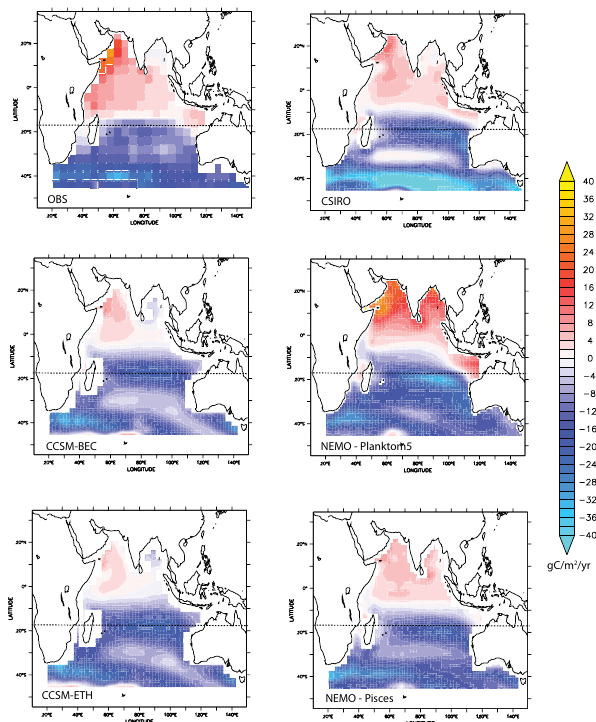
Fig. 4. Annual mean uptake, in gCm 2 yr − 1 , from the five ocean bio- geochemical models and observations; negative values reflect fluxes into the